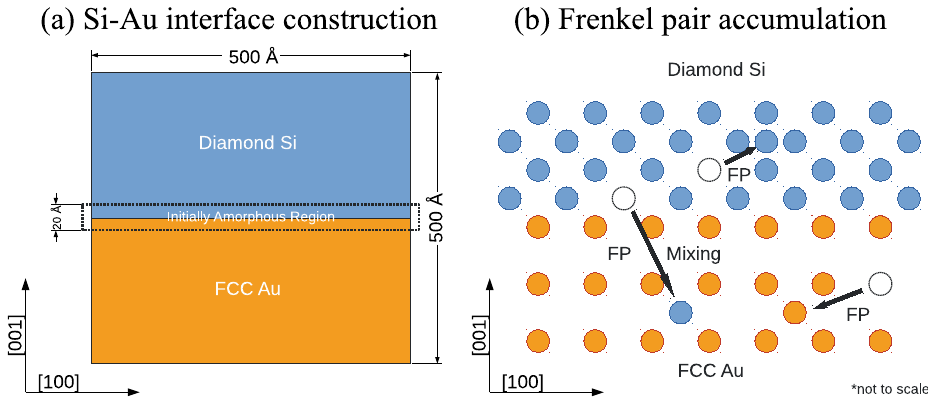
Figure 7. Simulation setup diagrams. ( a ) Construction of the Si–Au nanocomposite with an initial amorphous region. ( b ) Frenkel Pair Accumulation (FPA)